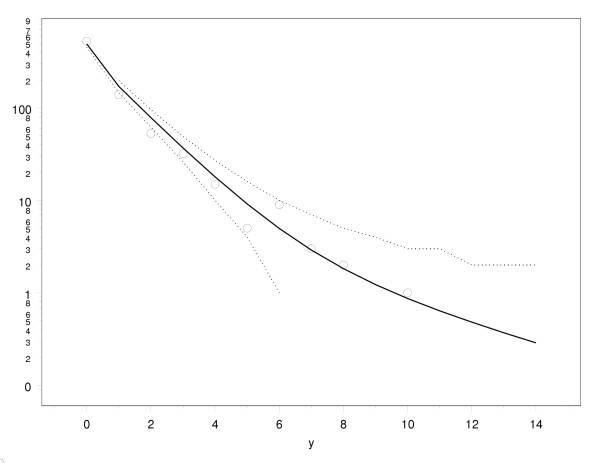
Frequencies of SAGE counts (restricted to genes mapped to a single tag) in IDC-3, given that the same tag had count one in HTM library 145. Compared to the expected frequencies and 95% confidence bounds from the bivariate model, restricted to tags with counts lower than 15 in both libraries.